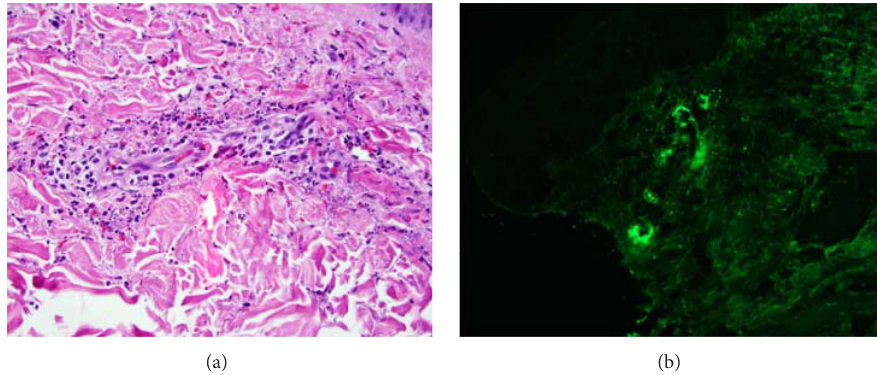
Figure 2: (a) High power hematoxylin and eosin stained slide showing leukocytoclastic vasculitis. (b) Direct immunofluorescence showing superficial dermal vascular depositions of